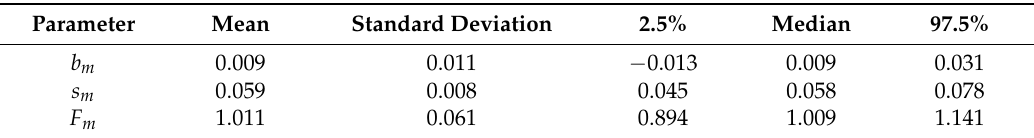
Table 4. Model validation statistic